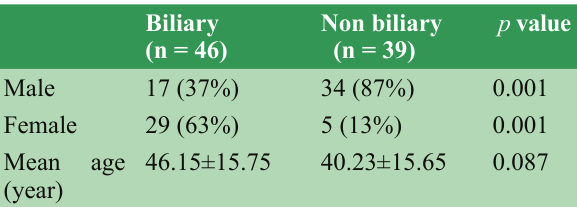
Table 2: Age and gender distribution of the patients